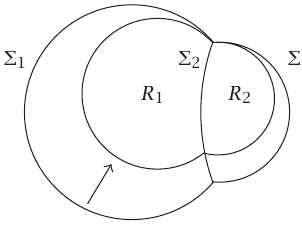
Figure 2.2 . Increasing the curvature of Σ Σ 2 fixed increases the curvature of